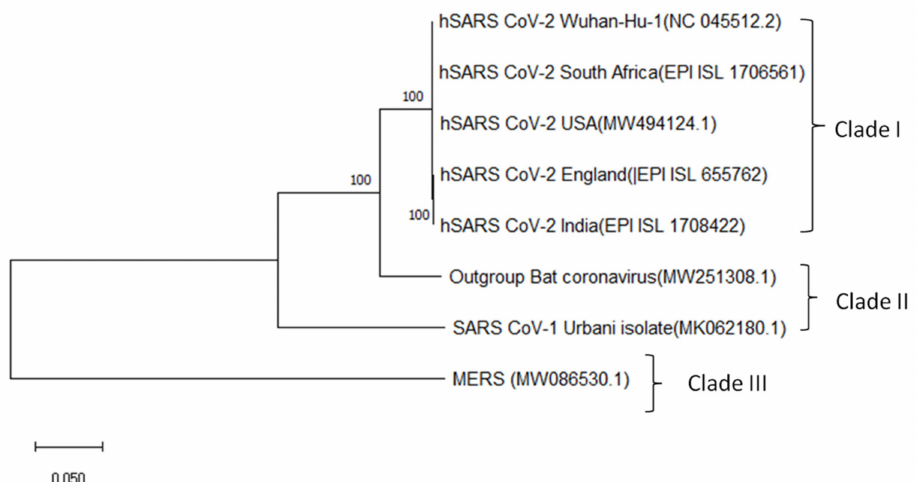
Figure 1. Maximum likelihood phylogenetic tree of SARS-CoV-2 genomes isolated from different geographical locations, namely Wuhan, England, the USA, India, and South Africa with reference to Bat Coronavirus, SARS-CoV-1, and MERS